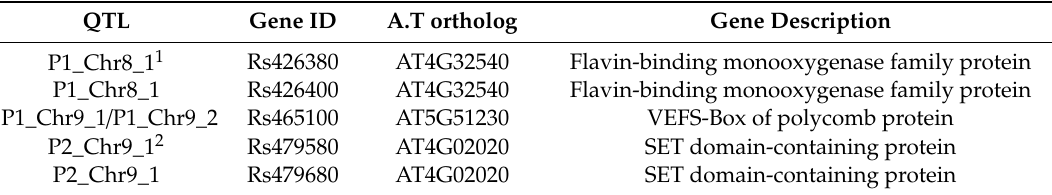
Table 6. List of Arabidopsis orthologs associated with plant regeneration near the QTL region. QTL Gene